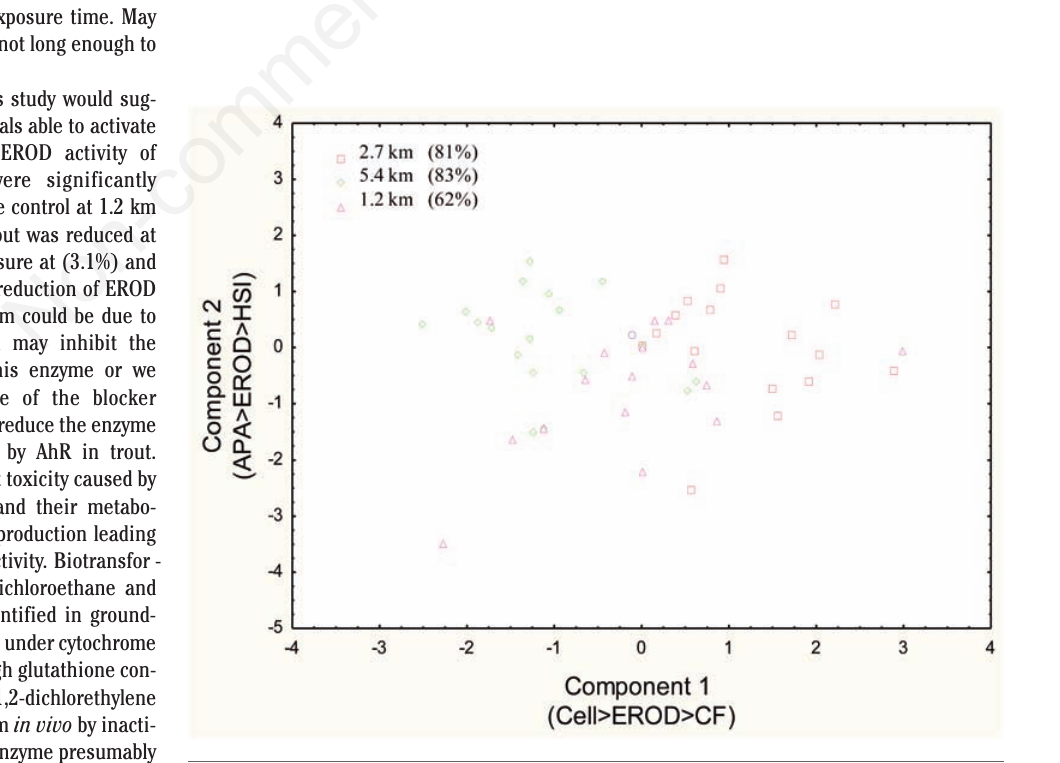
Figure 6. Results for discriminant function analyses for 14 days exposure to Mercier groundwater at 1.2 km, 2.7 km and 5.4 km. CF, condition factor; HIS, hepatosomatic index; Cell, cellularity; ethoxyresorufin- O -deethylase, APA and EROD